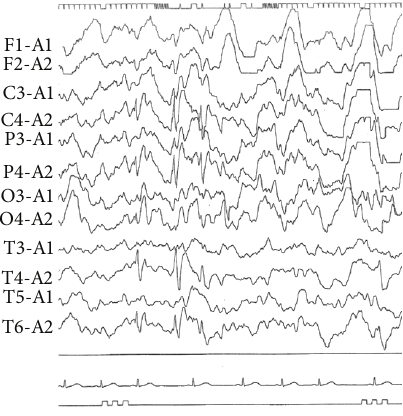
Figure 1: Electroencephalogram shows spike and waves at the C4-A2, P4-A2, T4-A2, and T6-A2 areas. These abnormal findings continue longer than one